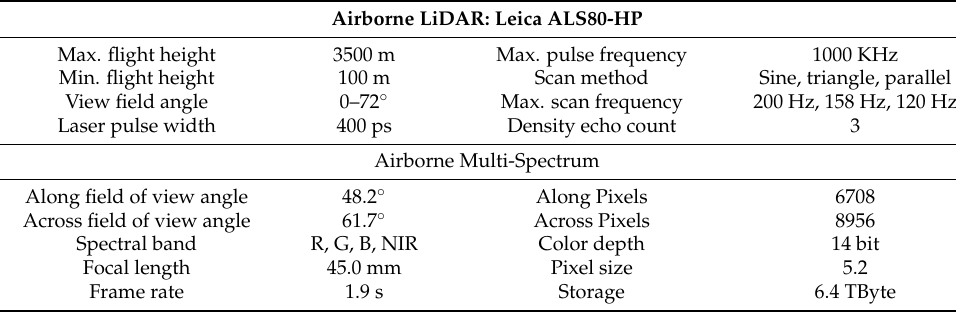
Table 1. Airborne integrated sensor system detailed parameters.